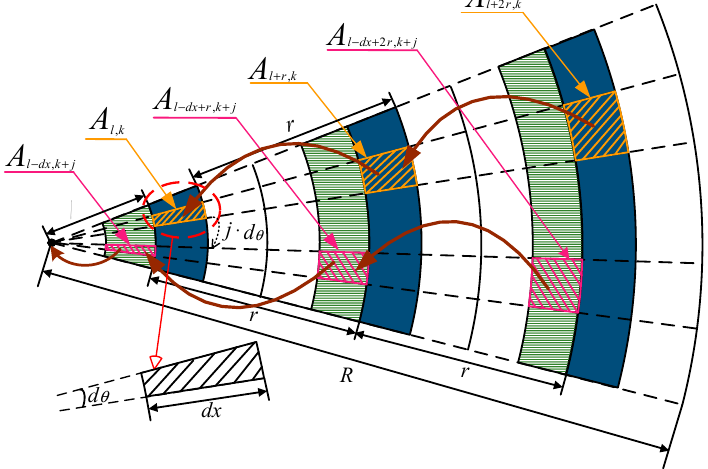
Figure 9. Network transmission structure.